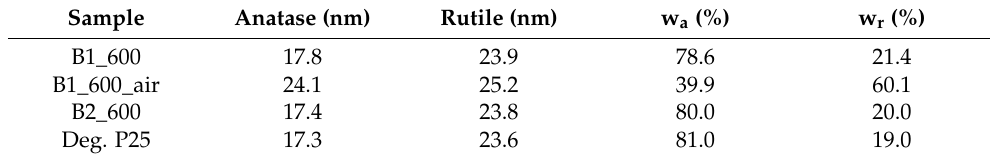
Table 3. Weight fraction of anatase and rutile phases and mean size of crystallites for all